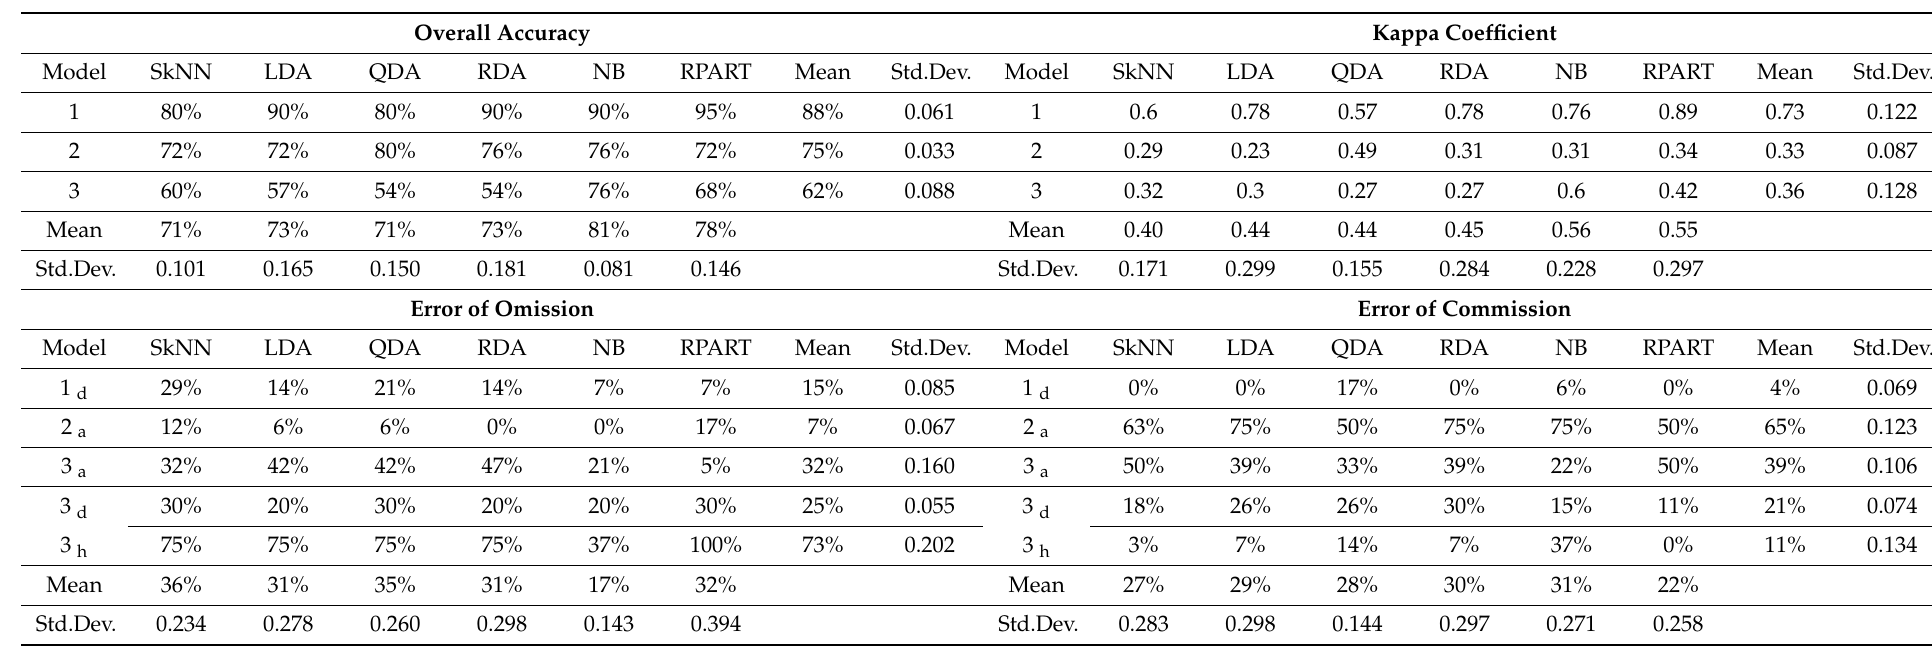
Table 3. Classification metrics corresponding to SkNN, LDA, QDA, RDA, NB, and RPART